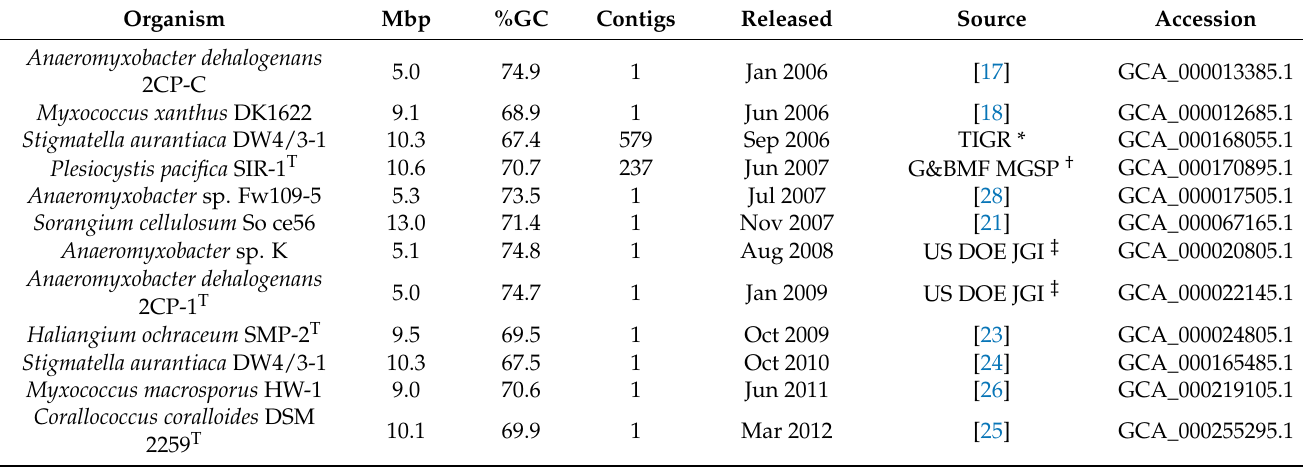
Table 1. The first 12 published myxobacterial genome sequences (as reported by Huntley et al. [19]), ordered by release date. Sequences without a reference were published variously by: * The Institute for Genomic Research, † The Gordon and Betty Moore Foundation Microbial Genome Sequencing project, or ‡ the United States Department of Energy Joint Genome